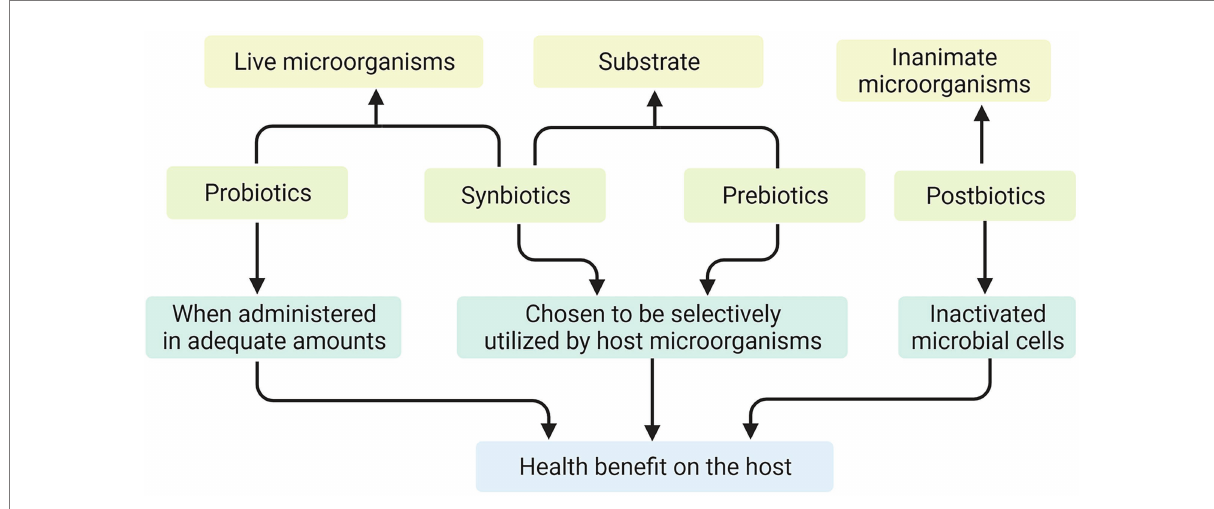
FIGURE 1 The mechanisms of action of probiotics, prebiotics, synbiotics, and